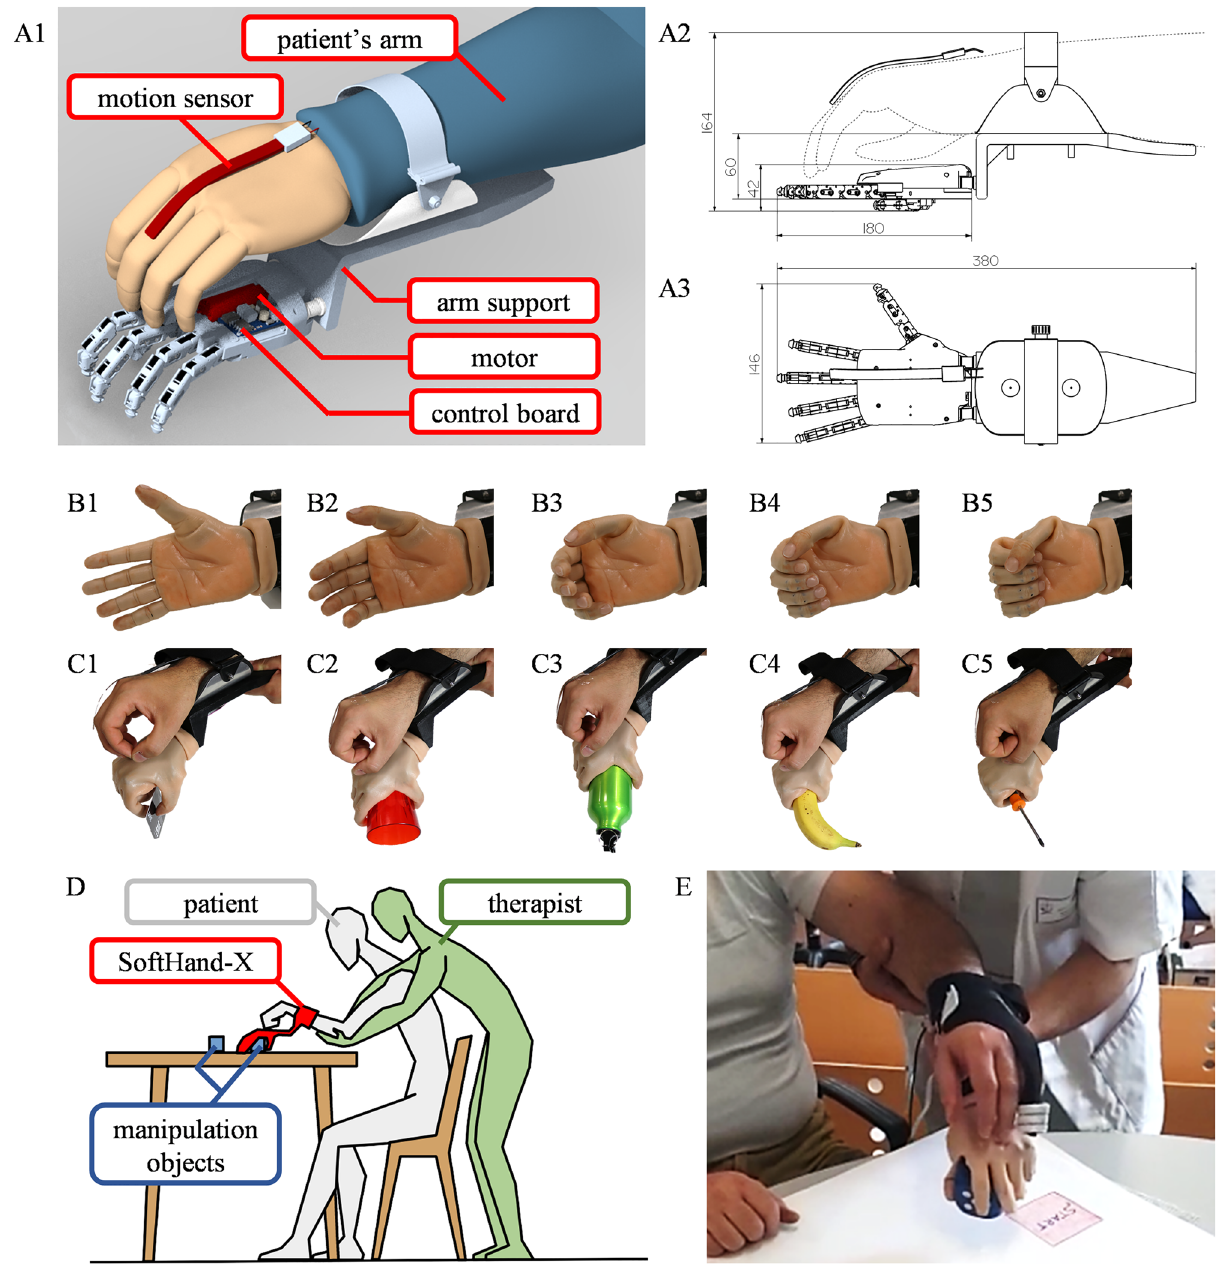
Figure 1. Rehabilitation setup. ( A1 ) SoftHand-X Supernumerary Robotic Hand and its main subsystems, including the hand hardware and the sensing system used to convert motions of the patient into motions of the robot, top view ( A2 ) and side view ( A3 ), with main system dimensions (in mm). ( B ) Photographic sequence ( B1 , B2 , B3 , B4 , B5 ) of the motion pattern of the supernumerary robotic hand, inspired to the most statistically frequent human hand motion, described in literature as the first postural synergy of grasping. ( C ) Grip patterns of the soft supernumerary robotic hand conforming to the shape of different objects to achieve a natural-looking grasp posture: ( C1 ) a credit card, ( C2 ) a drinking glass, ( C3 ) a bottle, ( C4 ) a banana, and ( C5 ) a screwdriver. ( D ) Illustration of the full rehabilitation scenario: a patient (white) is sat comfortably and wears the supernumerary limb (red); a therapist (green) guides the patient in the manipulation of objects (blue) resting on a table. ( E ) Close-up picture of one of the rehabilitation phases: the patient must reach a plastic cube placed on the table, grab it, and then release it. The physiotherapist supports the arm and forearm, facilitating the patient’s proximal movements. The grip and release movements are performed through the robotic hand under patient’s control, without the help of the